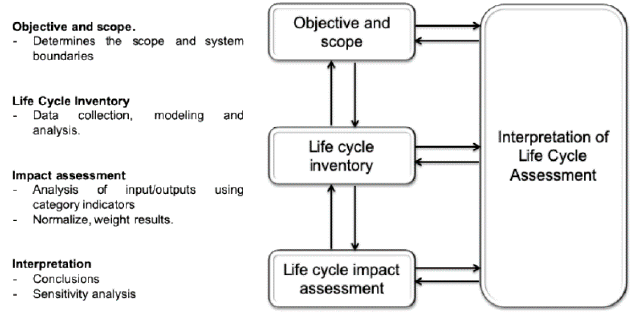
Figure 1. Life cycle assessment (LCA) framework. Adapted from ISO